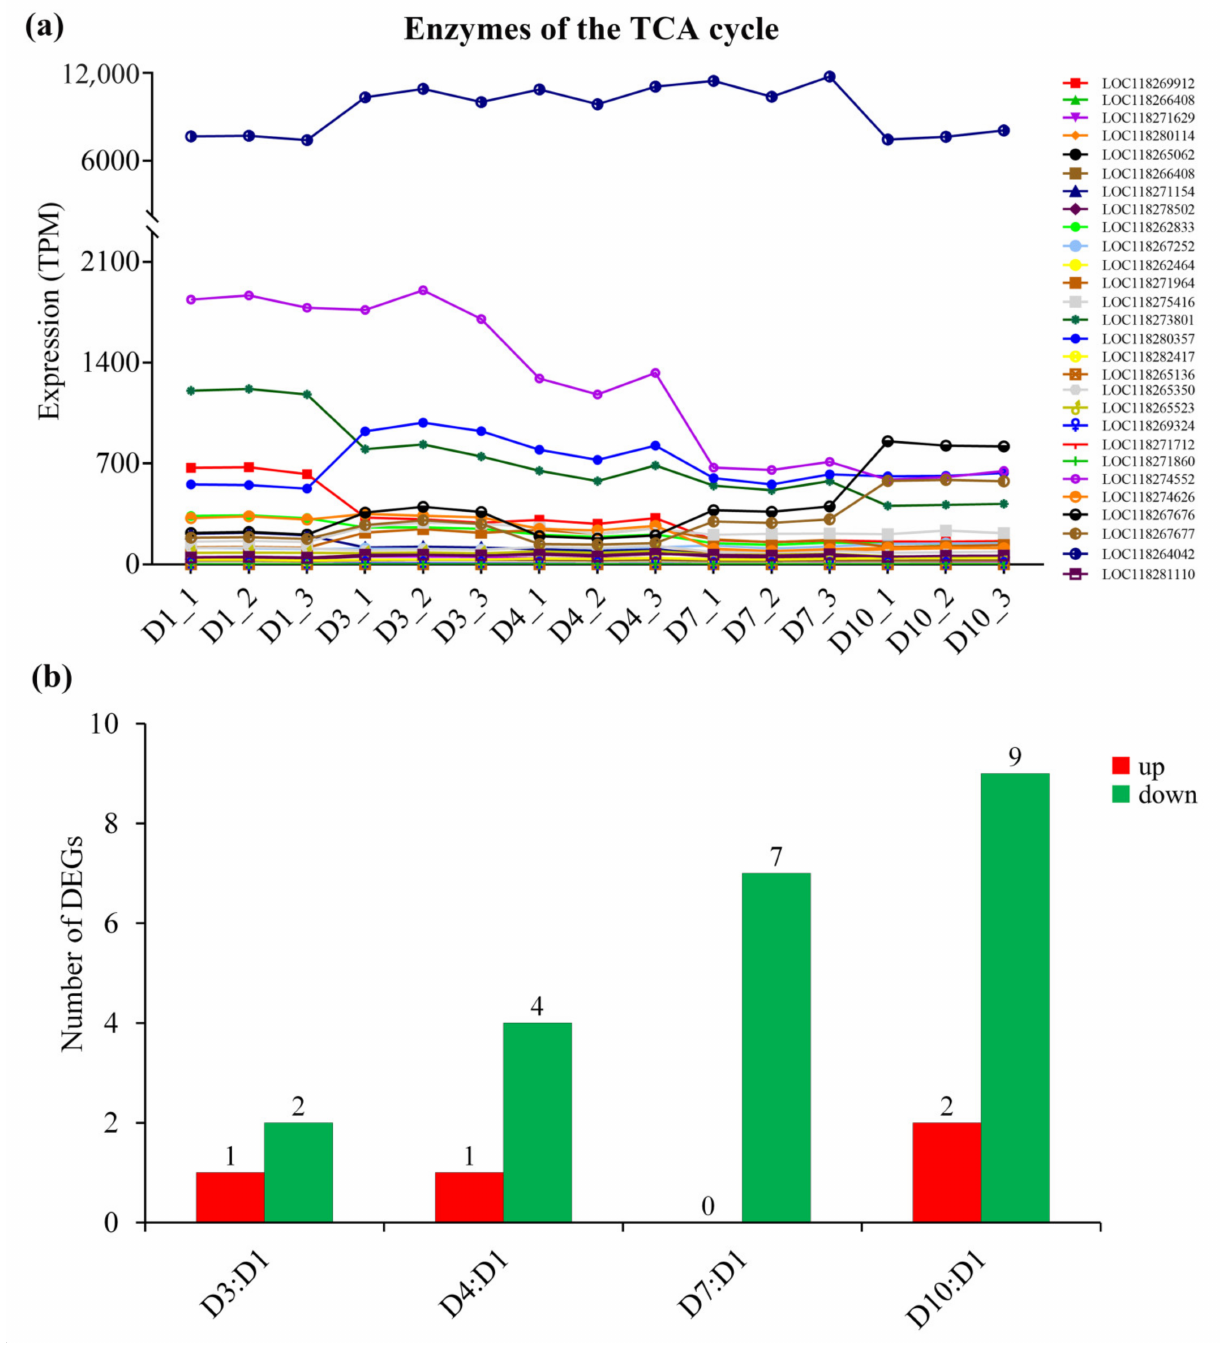
Figure 7. The expression of enzymes of the tricarboxylic acid (TCA) cycle in S. frugiperda females at different ages. ( a ) Changes in enzyme gene expression with age; ( b ) DEGs of D3:D1, D4:D1, D7:D1 and D10:D1 groups, wherein red columns represent upregulated DEGs and green columns represent downregulated